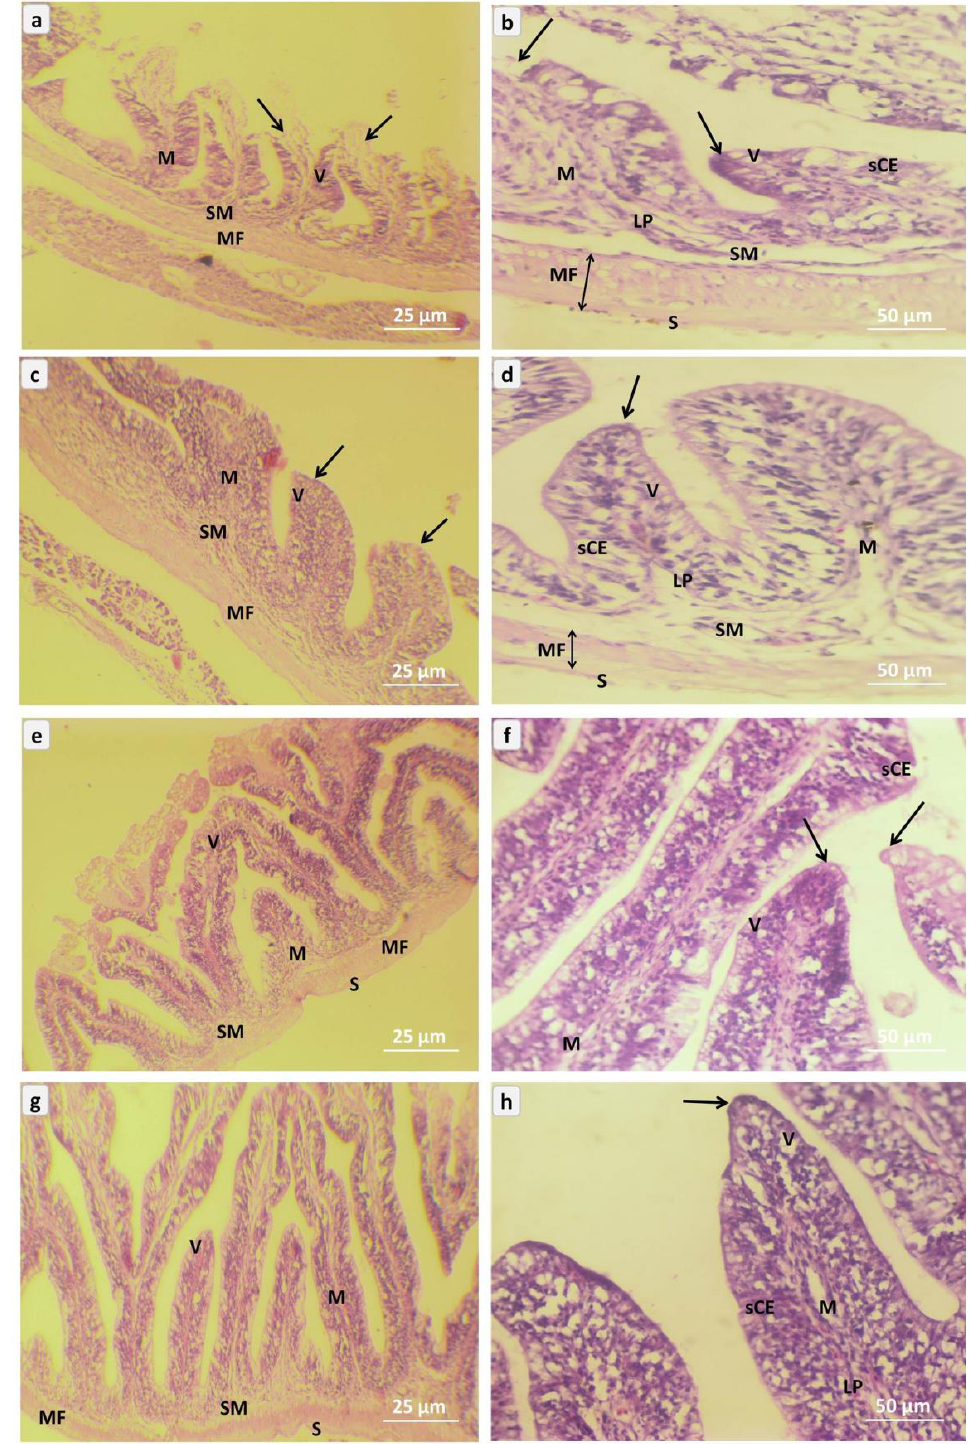
Figure 4. Representative micrograph of intestinal sections of red tilapia ( Oreochromis sp.) challenged with Aspergillus flavus , ( a,b ) → NC0, ( c,d ) → NC1, ( e,f ) → NC2, ( g,h ) → NC3. NC0: control diet; NC1: nanocurcumin 40 mg/kg diet; NC2: nanocurcumin 50 mg/kg diet; NC3: nano curcumin 60 mg/kg diet. S = layer of serosa, MF = layers of mucosal fibers, SM = layer of the submucosa, M = layer of mucosa, V = villi, sCE = simple columnar epithelial tissues, LP = lamina propria, arrows = apical portion of intestinal villi. (H&E, Bar = 25 µ m and 50 µ